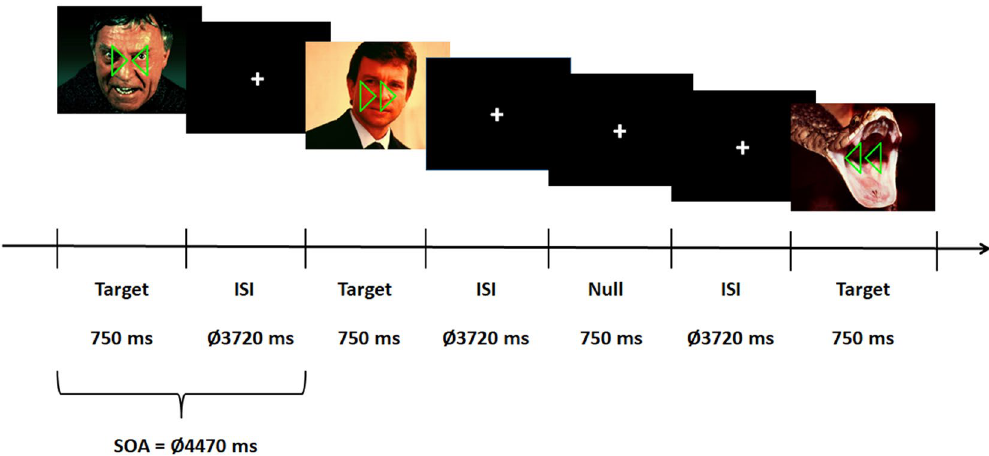
Figure 1. Experimental procedure. Participants were requested to identify whether the prompted picture was threat or neutral in the explicit task condition and whether the triangles that overlaid the pictures pointed to the same direction or to different directions in the implicit task condition. SOA stimulus onset